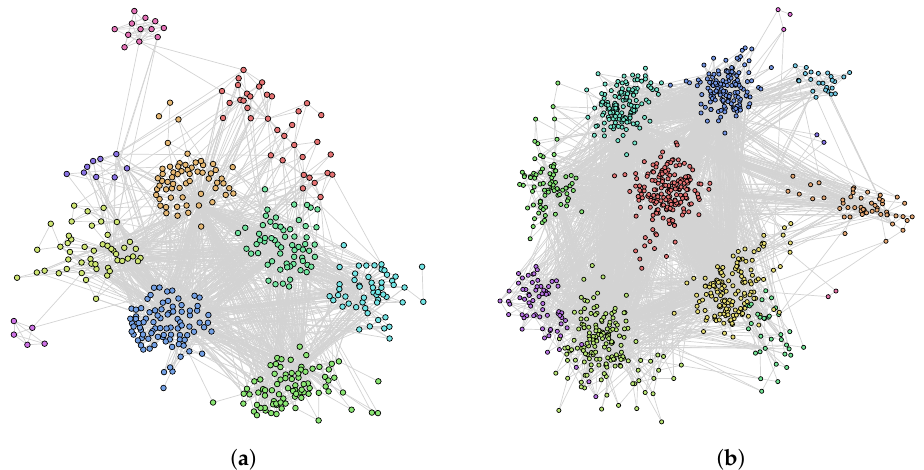
Figure 7. Community structure identified by H YBRID -IA on ( a ) C. elegans MRN and ( b ) E. coli MRN